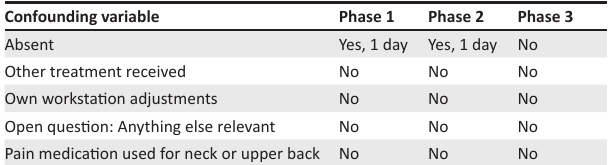
TABLE 5: Assessment of known confounders (end of phase).